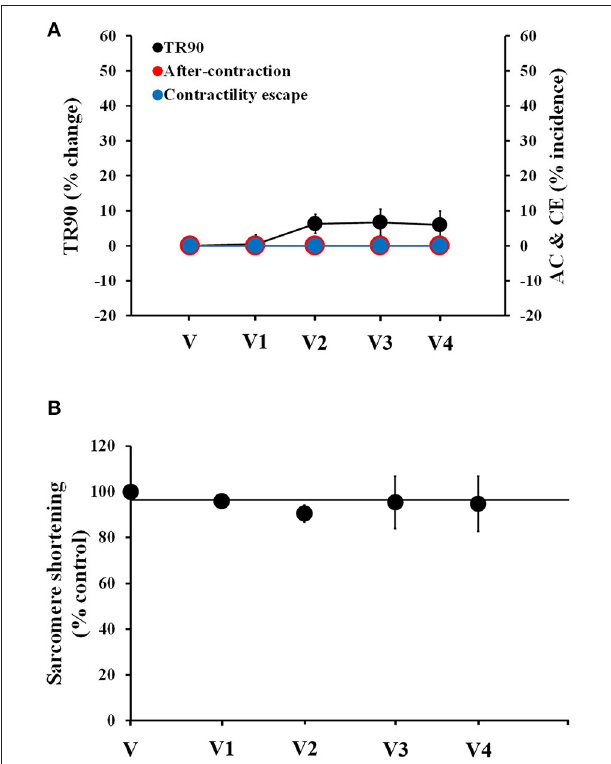
FIGURE 1 | Stability of contractility recordings over time in human cardiomyocytes. (A) Change in TR90 and % incidence of AC and CE induced by sequential additions of vehicle (V) in human cardiomyocytes at 1Hz pacing frequency. P > 0.05 vs. V-values. (B) Vehicle effect curve for sarcomere shortening. V1, V2, V3, and V4 correspond to the 1st, 2nd, 3rd, and 4th applications of